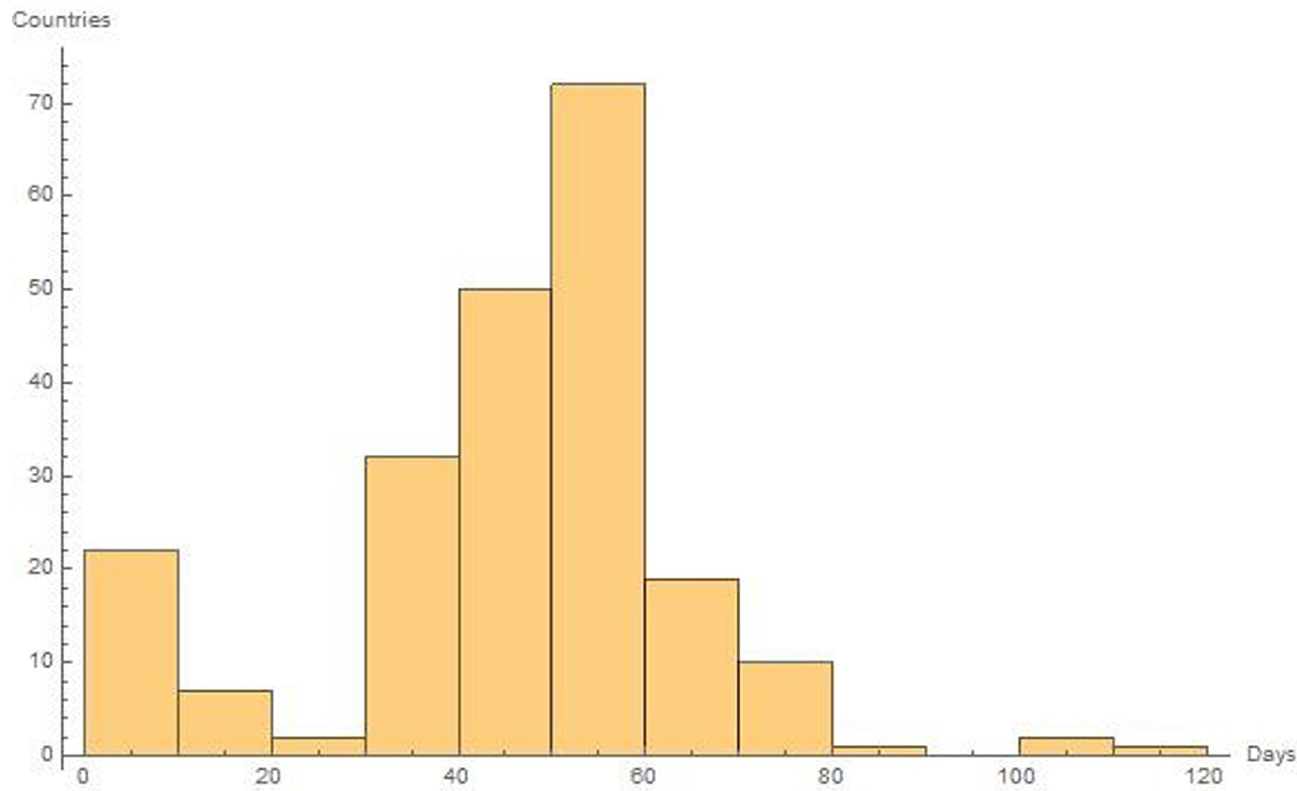
Fig 3. Twofold trends in the development of the pandemic all over the world. As it is possible to see, after an initial stasis of the contagion, as the days progress, the pandemic spread significantly continues and then decays.